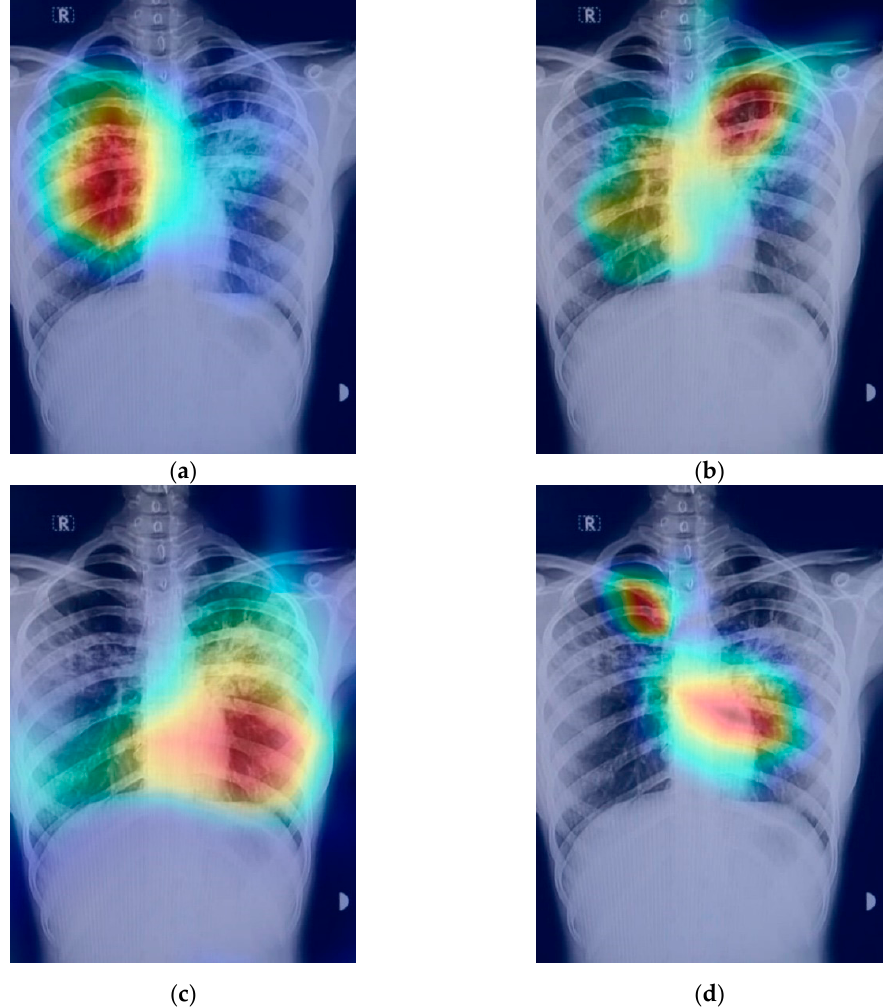
( d ) Figure 15. Results of prediction on a verified local Pakistani normal chest X-ray: ( a ) DenseNet-121; ( b ) VGG16; ( c ) MobileNet; ( d ) ResNet-50. 4. Conclusions In this paper, we applied transfer learning technique with fine tuning on the four pre- trained models (VGG16, ResNet-50, MobileNet, and DenseNet-121) in order to detect COVID-19 using chest X-ray images acquired from a hospital in Pakistan. The models under study were trained using the dataset of more than 3600 COVID-19 and normal chest X-ray images, whereas an indigenously collected dataset of 450 X-ray images of Pakistani patients were used for testing and prediction purposes. Various important parameters, e.g., recall, specificity, F1-score, precision, loss graphs, and confusion matrices were used to validate the accuracy of the models. The VGG16 model exhibited the least accurate per- formance in classifying the COVID-19 and normal chest X-ray images; however, the DenseNet-121 displayed promising results in the classification of the COVID-19 and nor- mal images. The achieved accuracies of VGG16, ResNet-50, DenseNet-121, and MobileNet are 83.27%, 92.48%, 96.49%, and 96.48%, respectively. Furthermore, in order to highlight the area where the model is paying the most attention during feature extraction, the Grad- CAM technique was also applied to create class-specific heatmap images. Various opti- mizers were tested, and among all of the optimizers under study, the ‘RMSprop’ opti- mizer exhibited the best performance and hence was applied for the error minimization and better optimization in the training procedure.